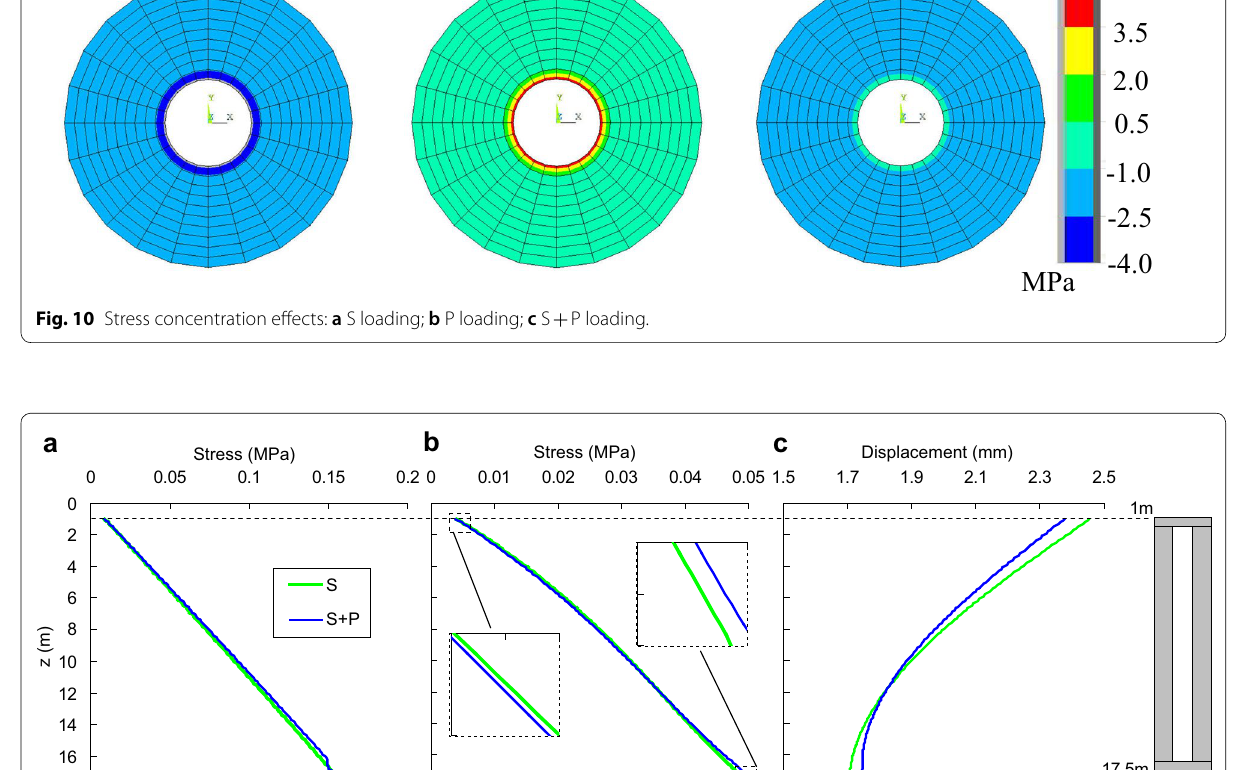
Fig. 11 Soil boundary forces: a lateral pressure ( P o ), b shaft friction stress ( f ); c vertical displacement of the